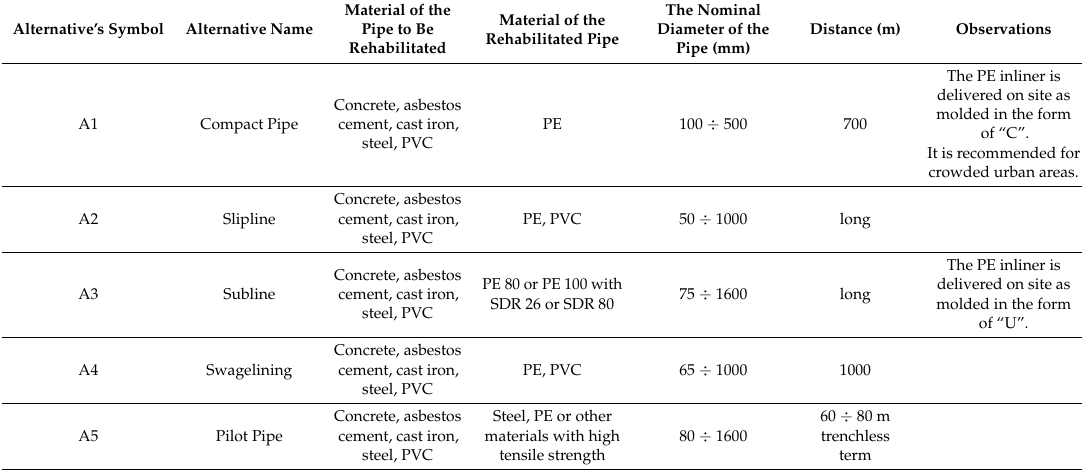
Table 2. Matrix of alternatives